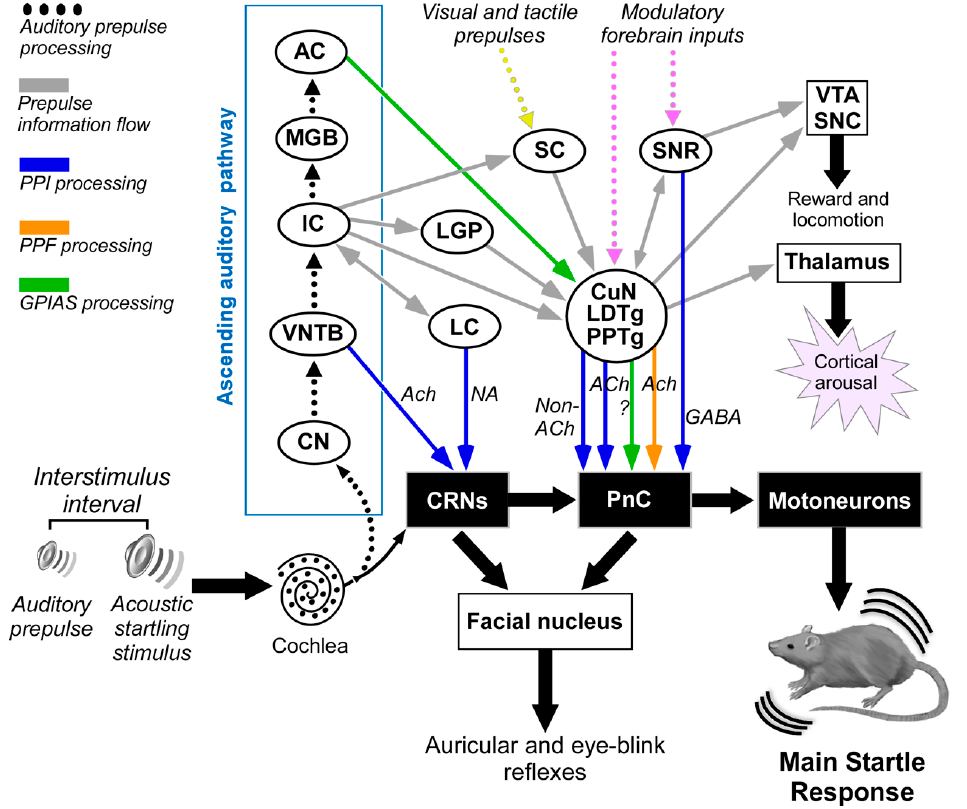
Figure 2. Multiple neuronal pathways for sensorimotor gating processes modulating the acoustic startle reflex in experimental animals. The auditory prepulse is processed through specific